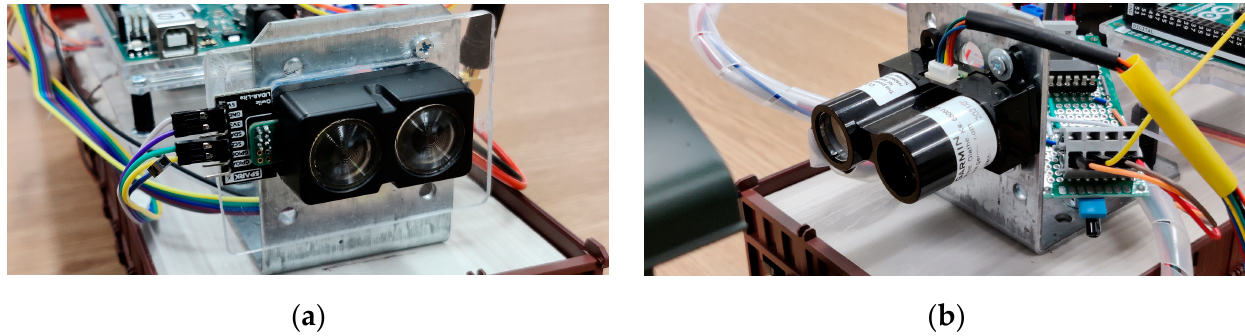
Figure 9. Two types of LiDAR sensors with different ranges: ( a ) 10 m LiDAR-Lite-V4, ( b ) 40 m LiDAR-Lite-V3.